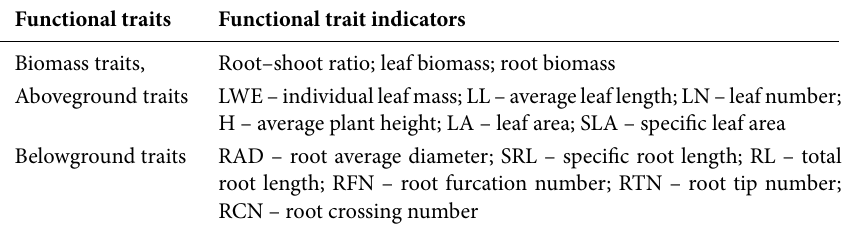
Table 1 Indicators of functional traits of tillering Stipa breviflora